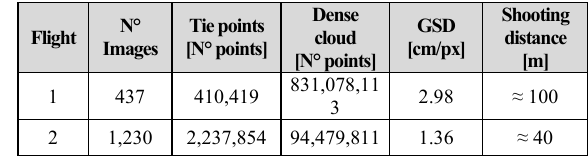
Table 1. Main details of the photogrammetric flights.